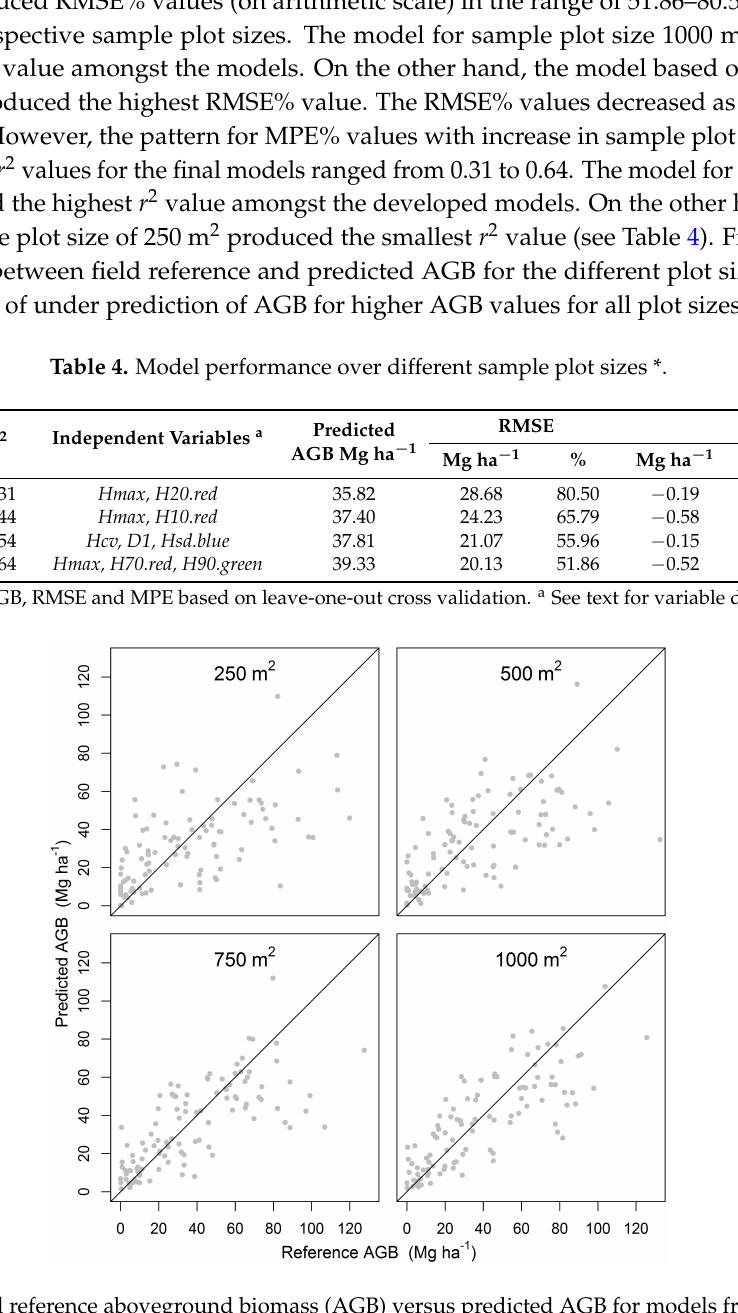
Figure 2. Field reference aboveground biomass (AGB) versus predicted AGB for models from different sample plot sizes, i.e., 250 m 2 , 500 m 2 , 750 m 2 and 1000 m 2 . The models contained a minimum of two and a maximum of three independent variables. All the models contained variables describing canopy height. Further, the models contained variables